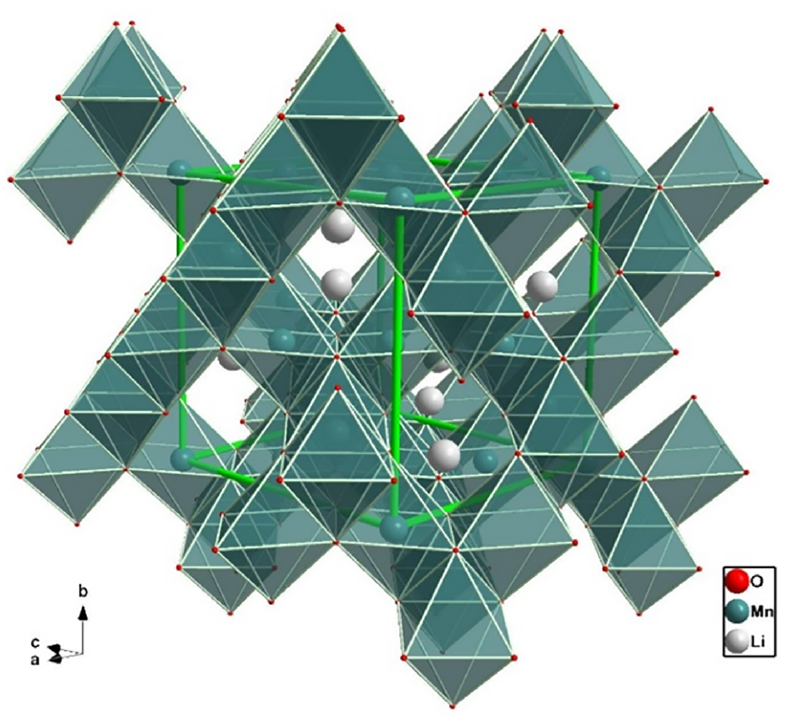
Figure 4. Cubic (spinel) structure of LiMn 2 O 4 . Space group: